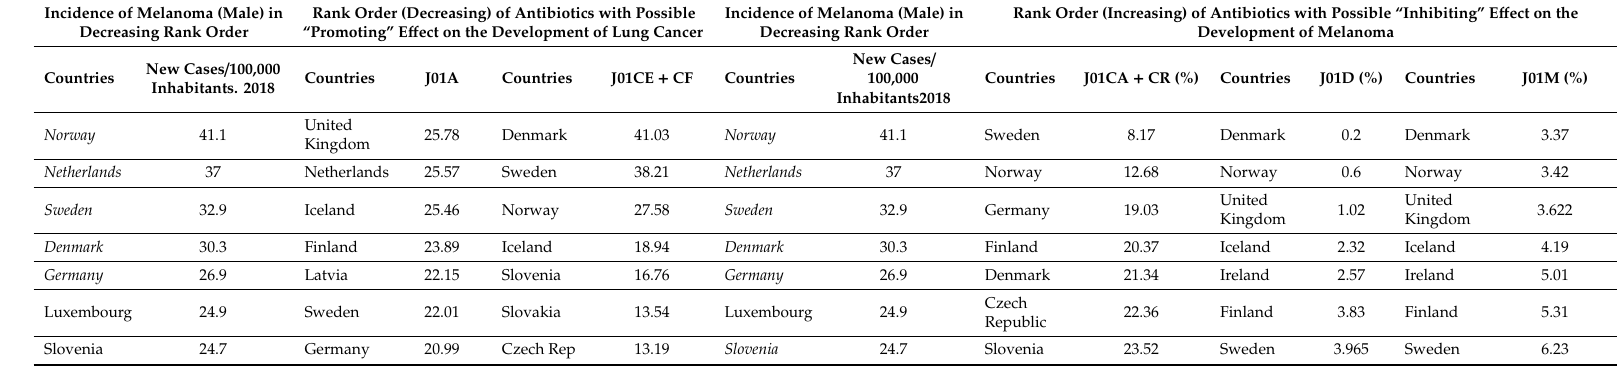
Table 7. Rank order of melanoma in males (decreasing) compared to the rank order (decreasing) of antibiotic consumptions of “promoting” and the rank order (increasing) of “inhibitor” e ff ect of antibiotics. Eight countries with the highest consumption of “promoting” antibiotics included in the first ten highest incidences of melanoma (males) countries. Eight of ten countries with the lowest consumption of “inhibitory” antibiotics are included in the first ten countries with the highest incidence of melanoma